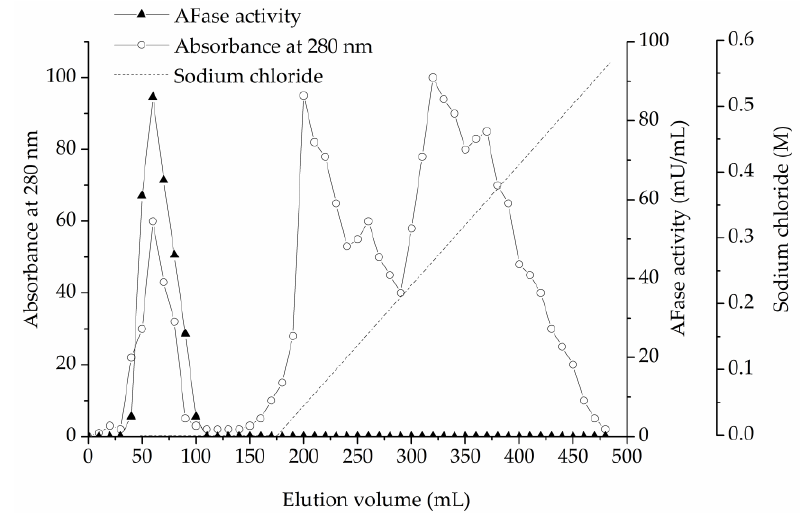
Figure 1. Ion-exchange chromatography of α-L-arabinofuranosidase (AFase) on diethylaminoethyl (DEAE) Sepharose Fast Flow.